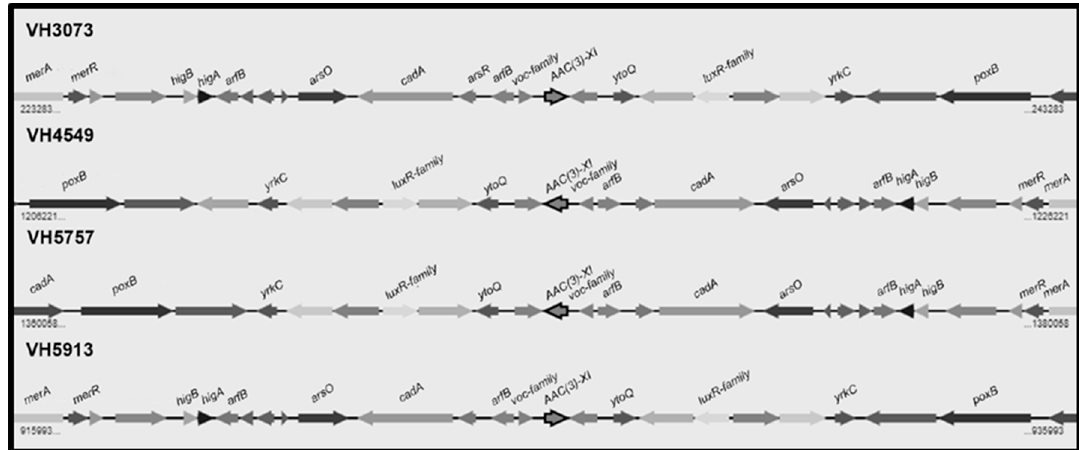
Figure 3. Genomic map of the region including the aac(3)-XI gene and its neighbors in four C. urealyticum clinical isolates: merA (mercuric ion reductase); merR (transcriptional regulator, MerR family); higB (toxin HigB); higA (antitoxin HigA); arfB (peptidyl tRNA hydrolase ArfB); arsO (flavin-dependent monooxygenase ArsO, associated with arsenic resistance); cadA (copper-translocating P-type ATPase); arsR (transcriptional regulator, ArsR family); voc family (VOC family protein); ytoQ (uncharacterized protein YtoQ); luxR -family (two-component transcriptional response regulator, LuxR family); yrkC (uncharacterized protein YrkC); poxB (pyruvate dehydrogenase).